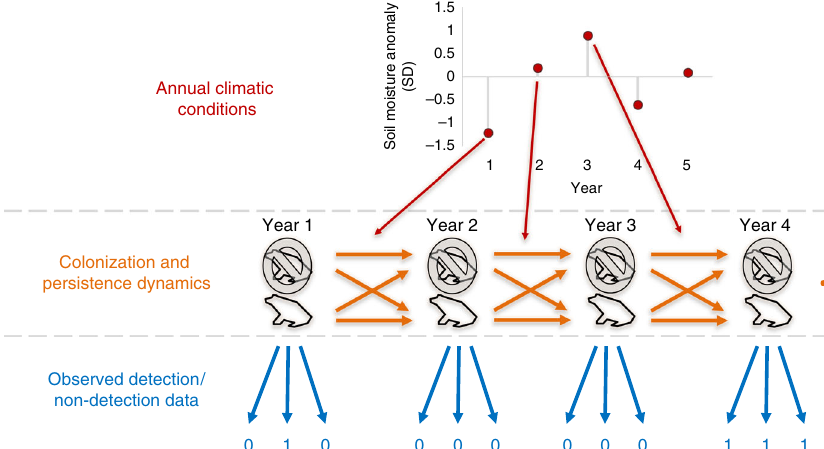
Fig. 2 Linking climate variability to local population dynamics. We linked annual variability in climate measures (e.g., winter severity, snowfall, water availability, soil moisture, and extreme summer temperatures) to occurrence dynamics while accounting for observational uncertainty (i.e., the probability of not detecting a species that was actually present during a visit). Our underlying model estimates the relationship between occurrence dynamics (whether a site is occupied in a year conditional on being occupied in the previous year — shown in orange) as a function of annual climate covariates (red arrows). We account for imperfect detection by relating the true occurrence state of sites to actual observed detections and non-detections (zeros and ones — shown in blue) as a function of study area and species-speci fi c detection probabilities. Based on the estimated relationship between annual environmental conditions and transition parameters (i.e., colonization and persistence probabilities), we were able to calculate how sensitive